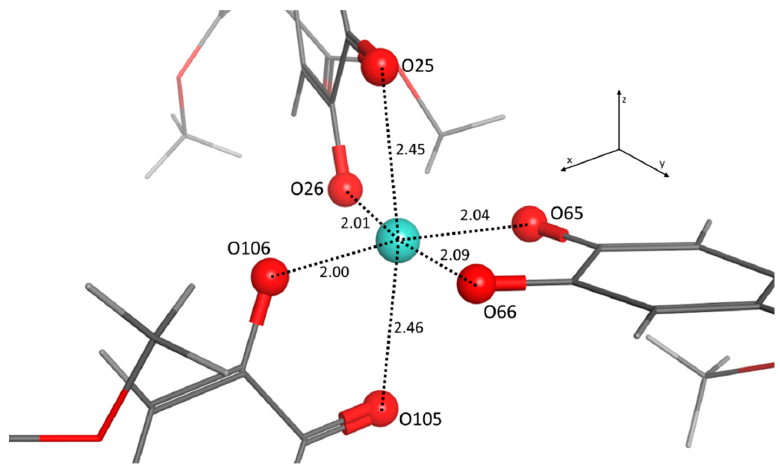
Figure 10. The geometry of the B3LYP / LANL2DZ optimized 1:3 Cu 2 + / compound 1 complex. Bond distances are showed in angstrom.